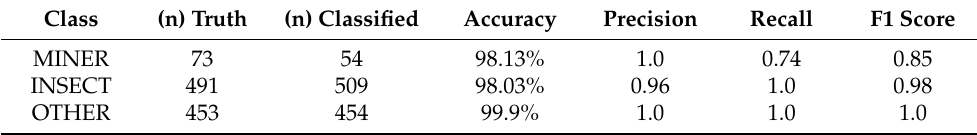
Table 2. Metrics per class in the model for the Pest Monitoring Device (PMD).